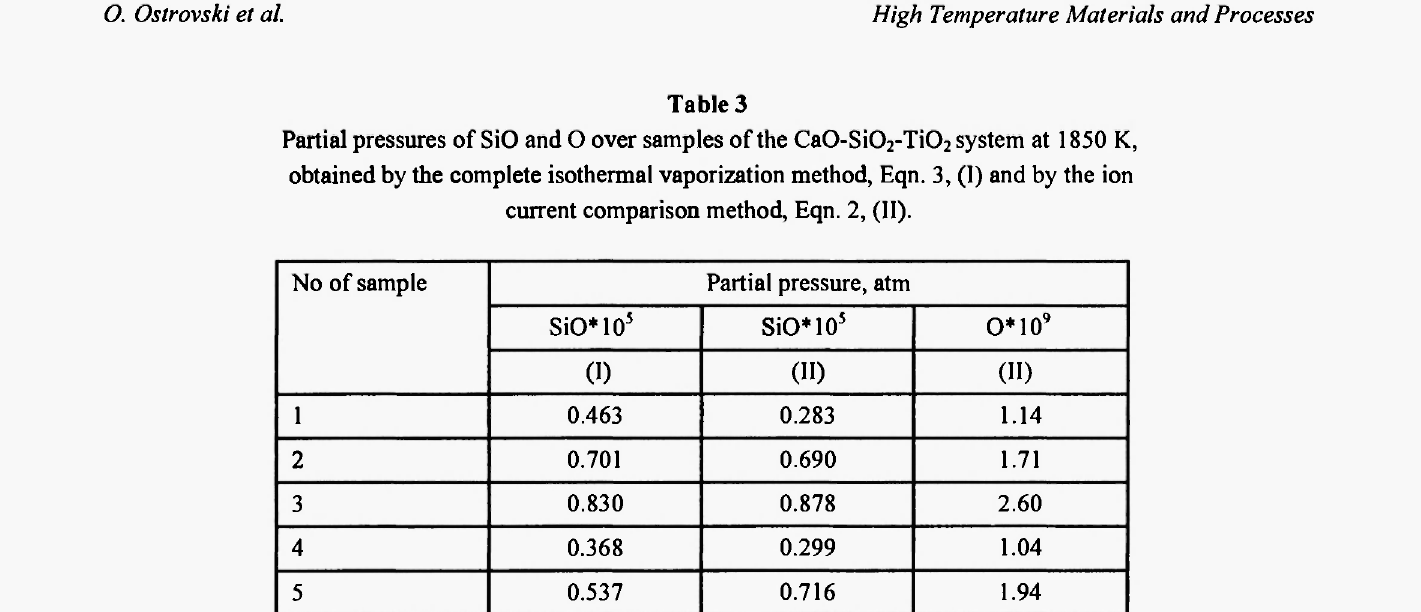
Partial pressures of SiO and Ο over samples of the Ca0-Si0 2 -Ti0 2 system at 1850 K, obtained by the complete isothermal vaporization method, Eqn. 3, (I) and by the ion current comparison method, Eqn. 2, (II).